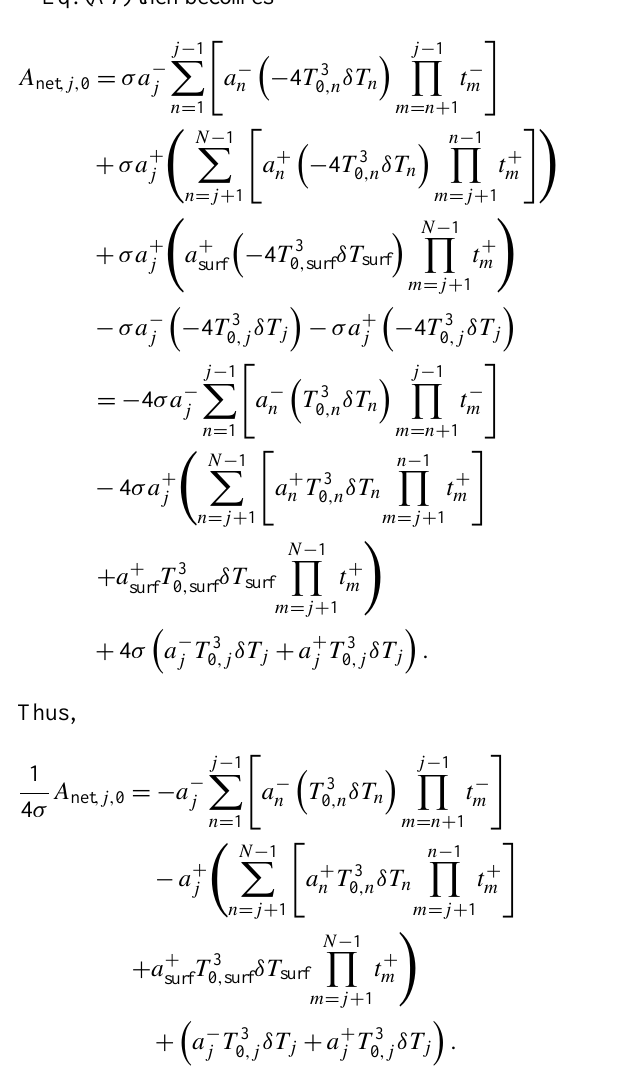
The upward ( a + ) and downward ( a − ) absorption coefficients are different because the spectral intensities of radiation inci- dent on the layer are different. The upward propagating long- wave radiation’s spectra is heavily influenced by the emission spectra of water vapour and the surface, whereas the down- ward propagating radiation’s spectra mainly emanates from the well-mixed greenhouse